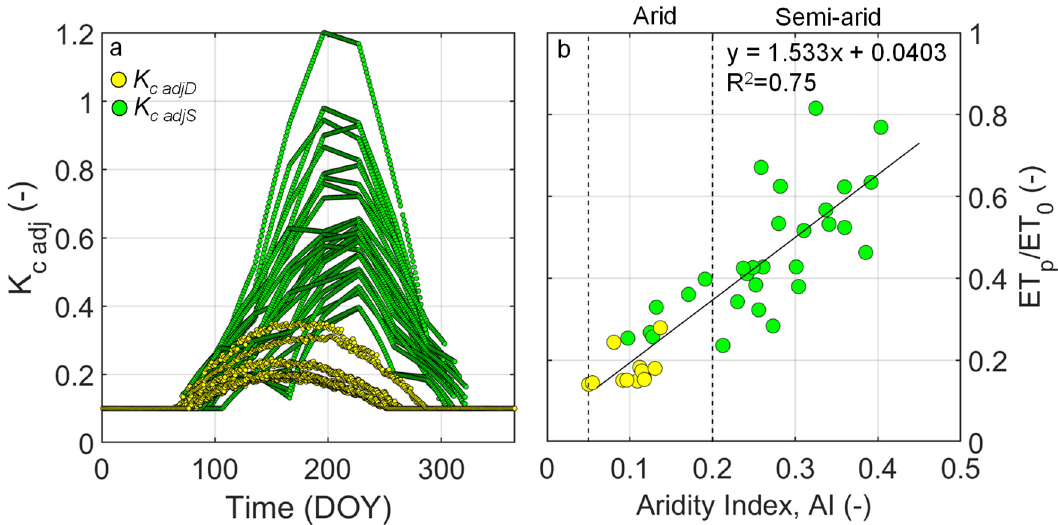
Figure 10. ( a ) daily K c adj values (DOY depicts day of the year) and ( b ) relationship between aridity index, AI, and mean annual ET p to ET 0 ratio over 41 weather stations in Mongolia. Solid black line represents linear regression equation reported with associated R 2 . Data are grouped according to natural vegetation zones, namely, steppe (green circles) and Gobi desert (yellow circles). Vertical dashed lines delimit climate classes (arid and semi-arid classes).